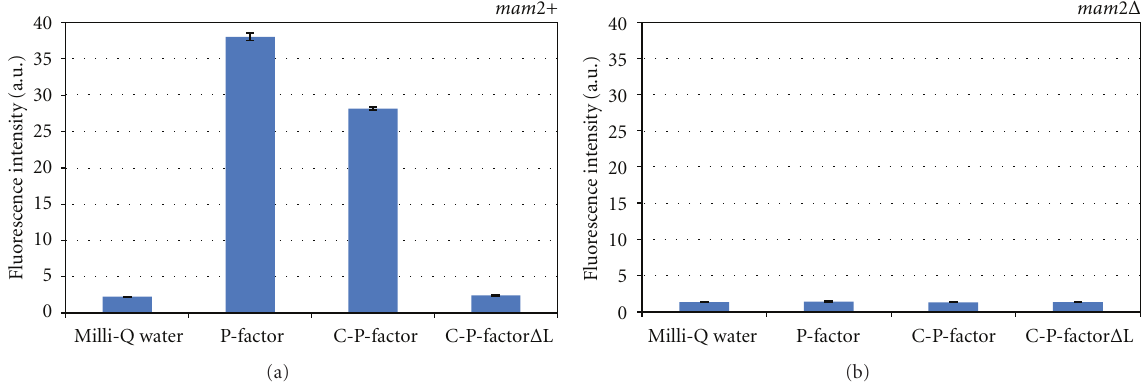
Figure 4: GFP production of mam2+ strain cell (a) and mam2 Δ strain cell (b). Under nutrition depletion, each cell was treated with Milli-Q water (control), 1 μ M of P-factor, C-P-factor, or P-factor Δ Leu. Values are means with SD of triplicate samples.